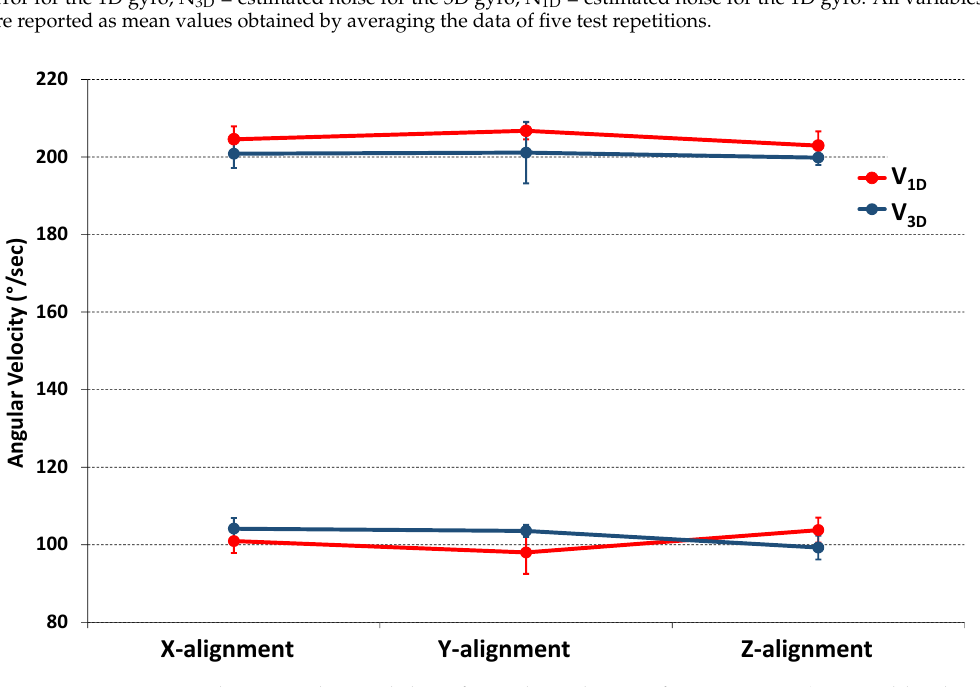
Figure 6. Comparison between the modulus of angular velocities from 3D gyro (V 3D , in blue line) detected for each X, Y, Z alignment and the single-axis angular velocity from 1D gyro (V 1D , in red line). Values were reported as mean ± SD from five test repetitions. |V T+ | = 200 °/s; |V T − | = 100 °/s.